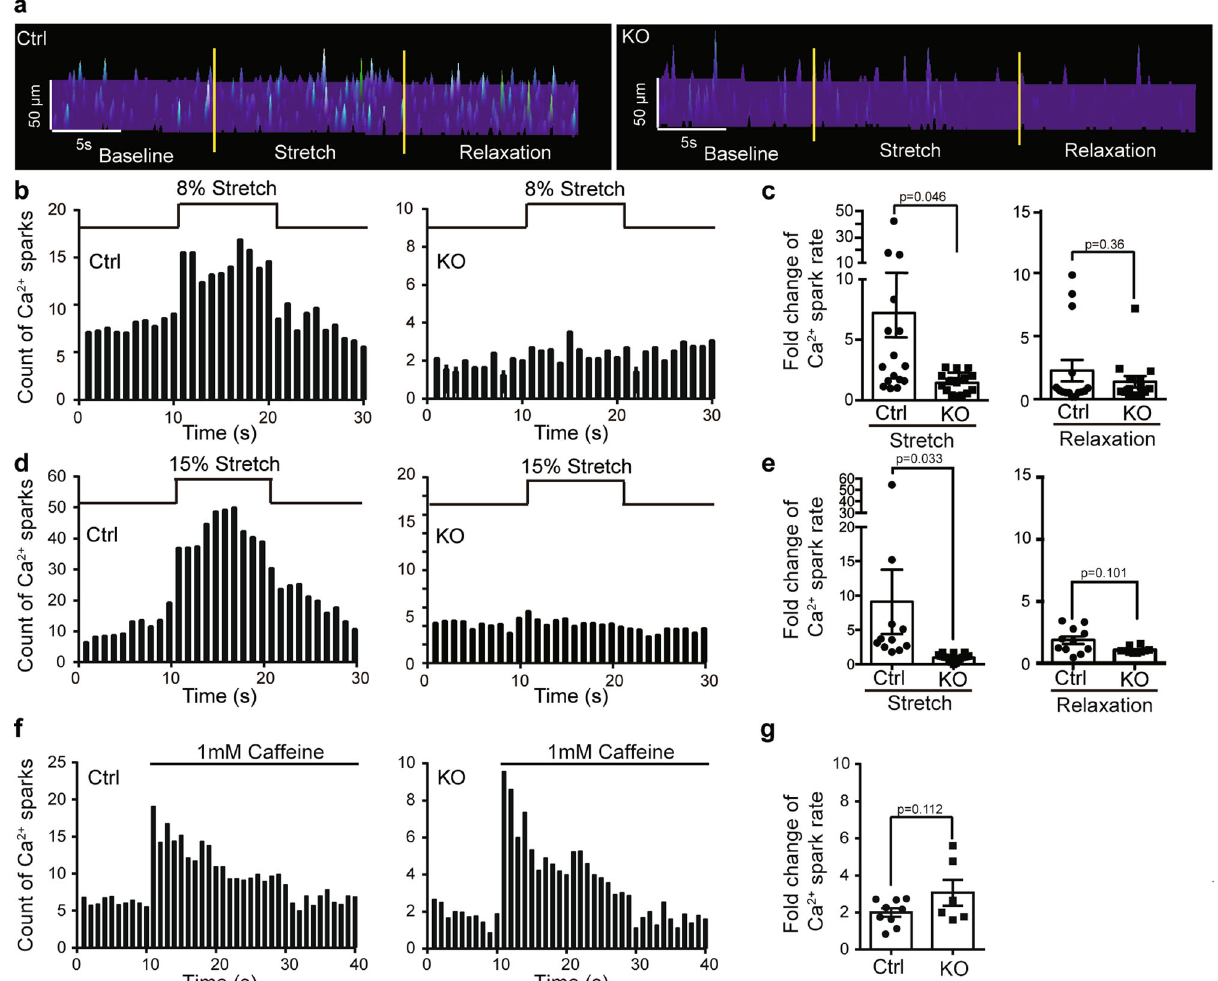
Fig. 3 Piezo1 mediates stretch-induced Ca 2 + signaling. a Representative fl uorescence surface plot of stretch-activated Ca 2 + sparks in Ctrl or KO cardiomyocytes in response to an 8% axial stretch. Ca 2 + sparks were detected using line-scan mode of confocal microscopy of the Ca 2 + indicator Fluo-4 AM. b Ca 2 + spark histogram before, during, and after 8% axial stretch of Ctrl (16 cells) and KO (17 cells) cardiomyocytes from KO ( n = 3) mice and